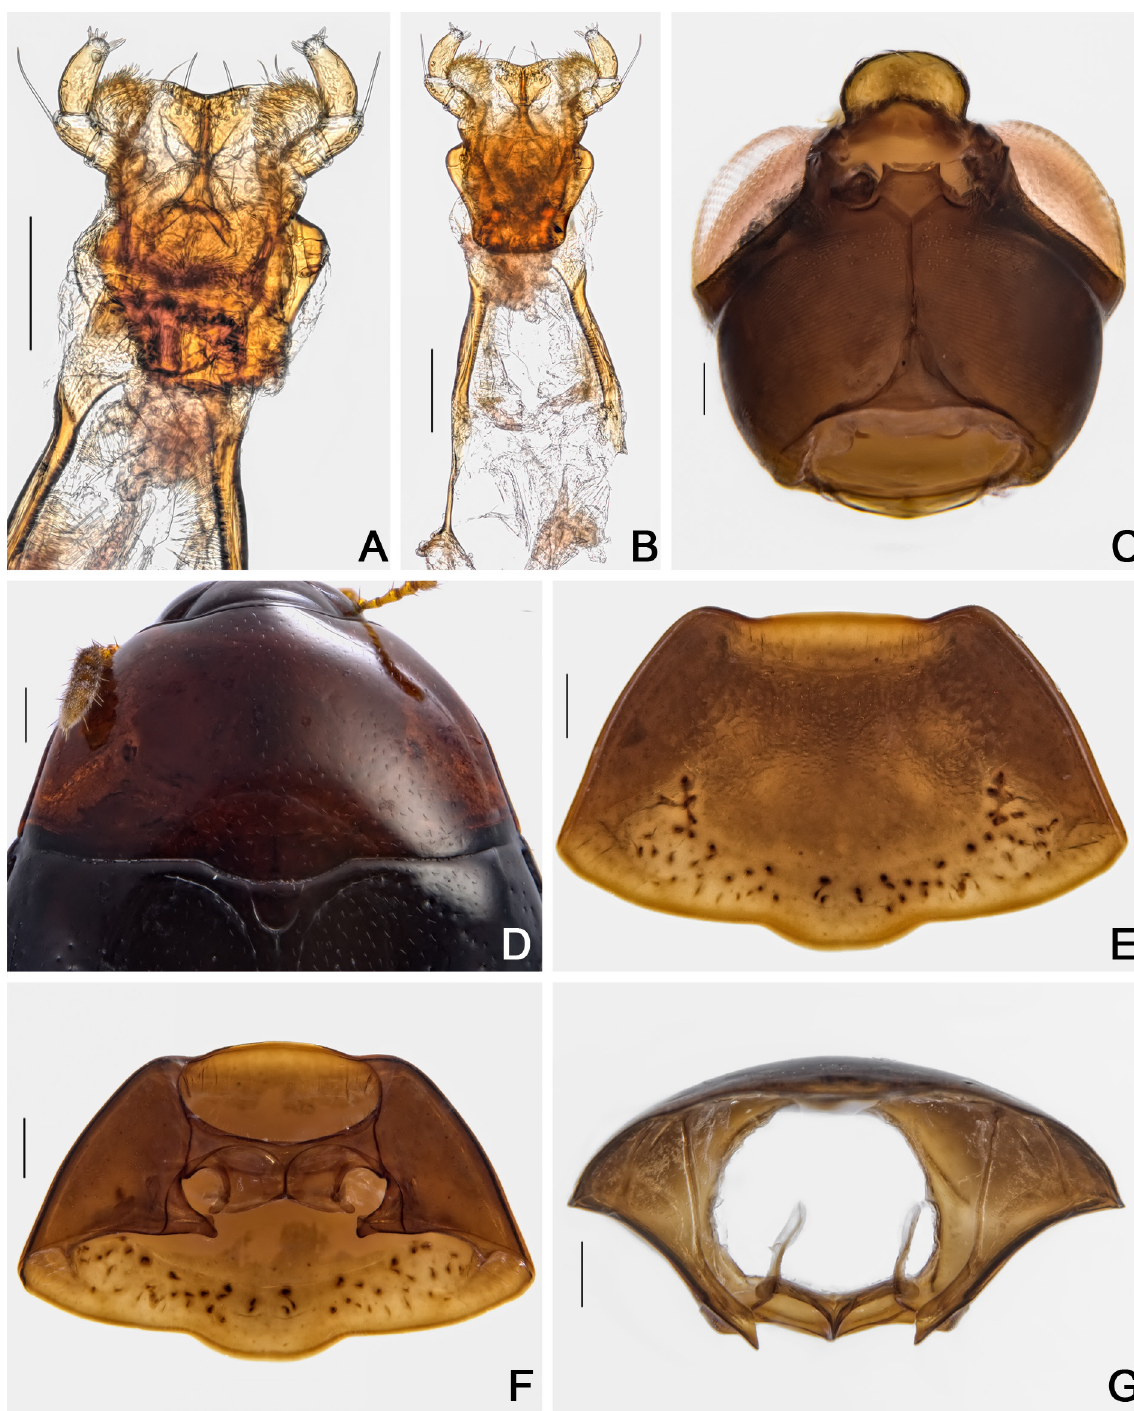
Fig. 49. Cyparium collare Pic, 1920, ♂♂ (CELC). A . Labium. B . Hypopharynx. C . Head, ventral view. D–E . Pronotum, dorsal view. F–G . Prothorax. F . Ventral view. G . Inner view. Specimens collected at Mata do Paraíso, Viçosa (MG, Brazil). Scale bars: A–C = 0.1 mm; D–G = 0.2